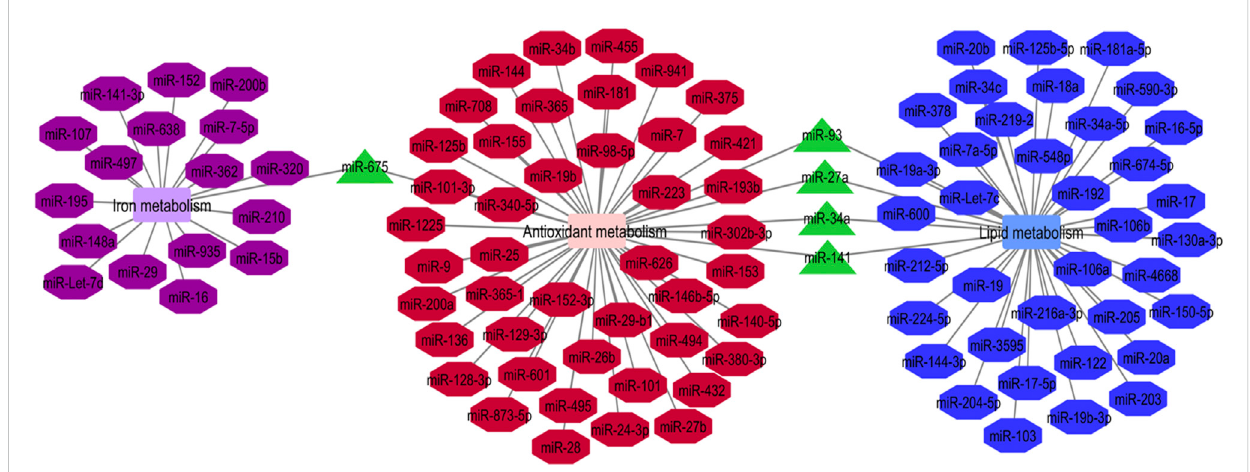
FIGURE 1 Ironmetabolism,antioxidantmetabolismandlipidmetabolismarethepivotalmechanismsintheferroptosisprocess.Thementionedmetabolisms- related miRNAs network was represented by Cytoscape software. The common miRNAs (miR-675, miR-93, miR-27a, miR-34a and miR-141) in these three networks with the most degree and betweenness centrality as the key miRNAs are shown by green triangles (Luo et al.,